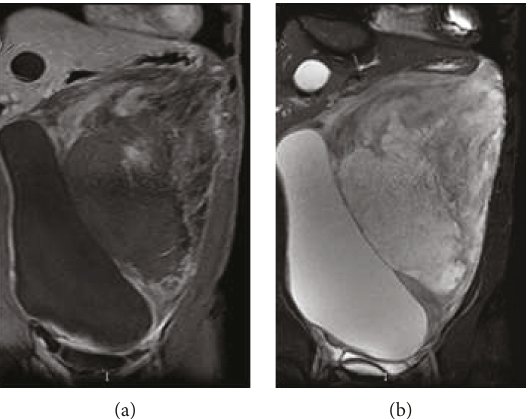
Figure 3: (a) MRI (coronal view, T1W1): tumor had generally low signal density, but some parts had high signal density. (b) MRI (coronal view, T2W1): tumor had high signal intensity.